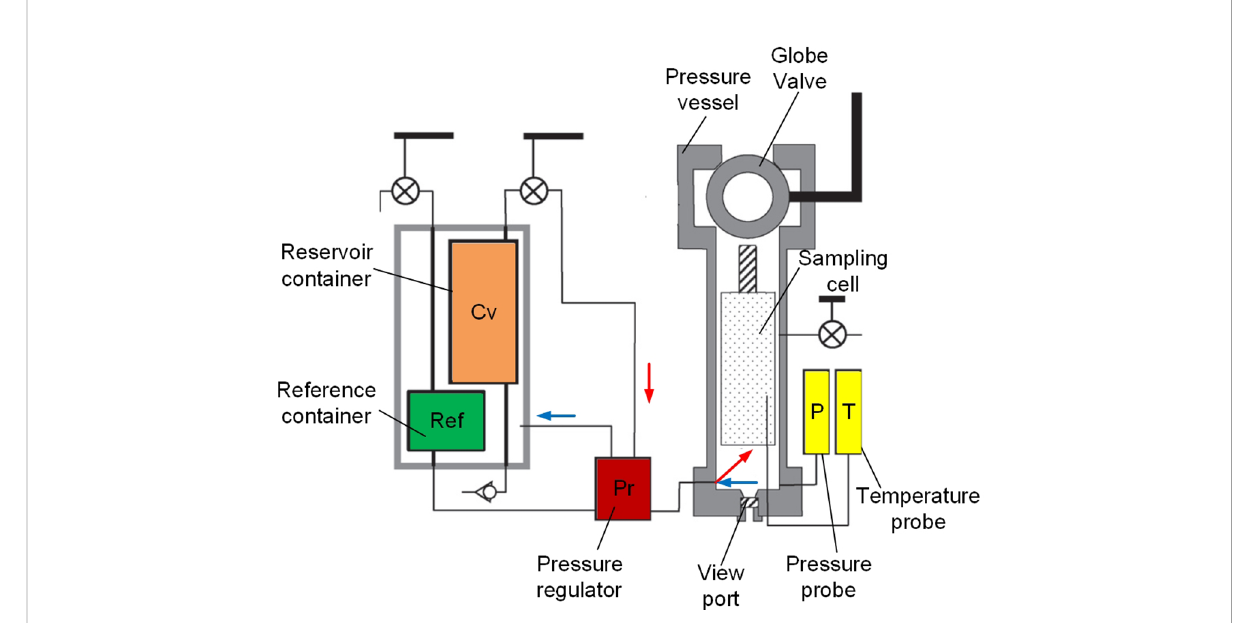
FIGURE 14 PRD of PERISCOP (Adapted from Shillito et al.,